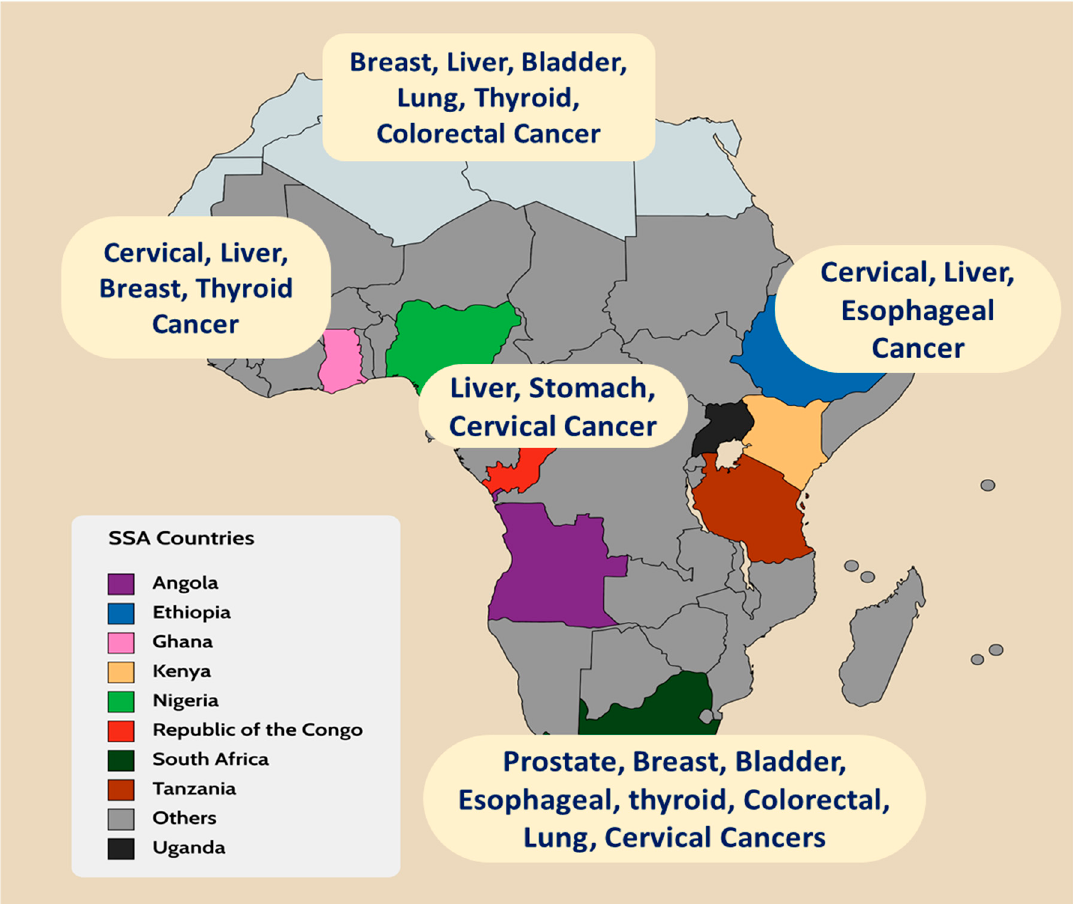
Figure 1. A map of Africa depicting the predominant cancer types in specific regions.